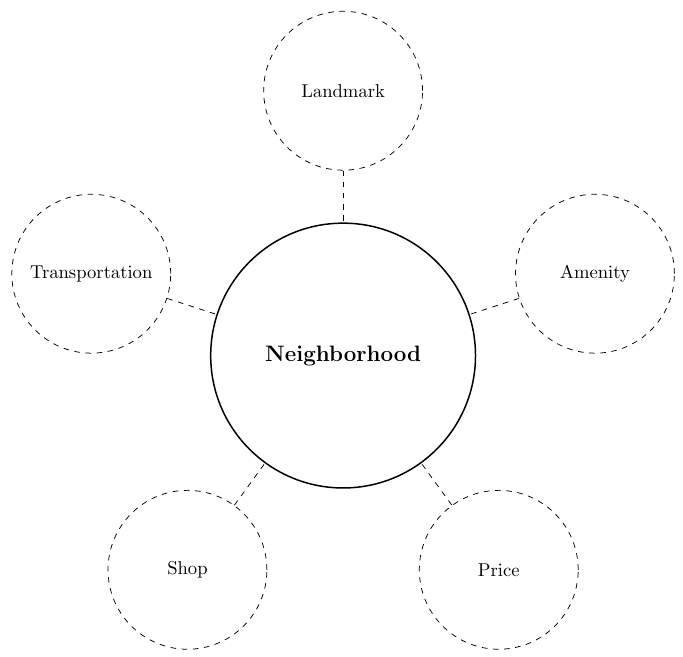
Figure 4. A fragment of the proposed ontology depicting a particular area of